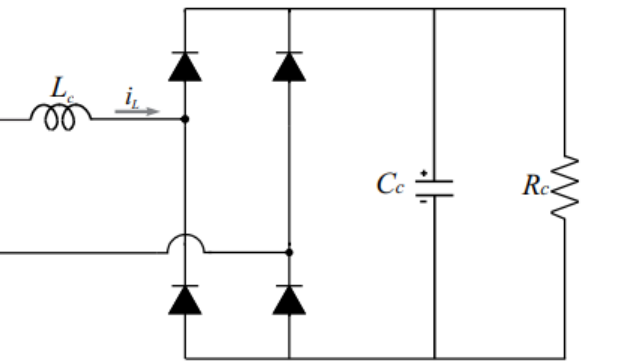
Figure 1. Nonlinear load and shunt APF connected to the grid at the PCC. Table 1. Parameters of the system under study.